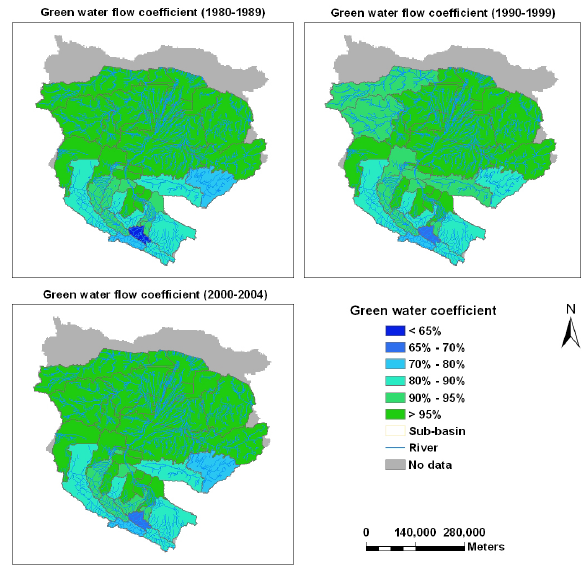
Fig. 8. The green water coefficient (the best simulation and long term average annual values) from the 1980s to the 2000s in the Heihe River